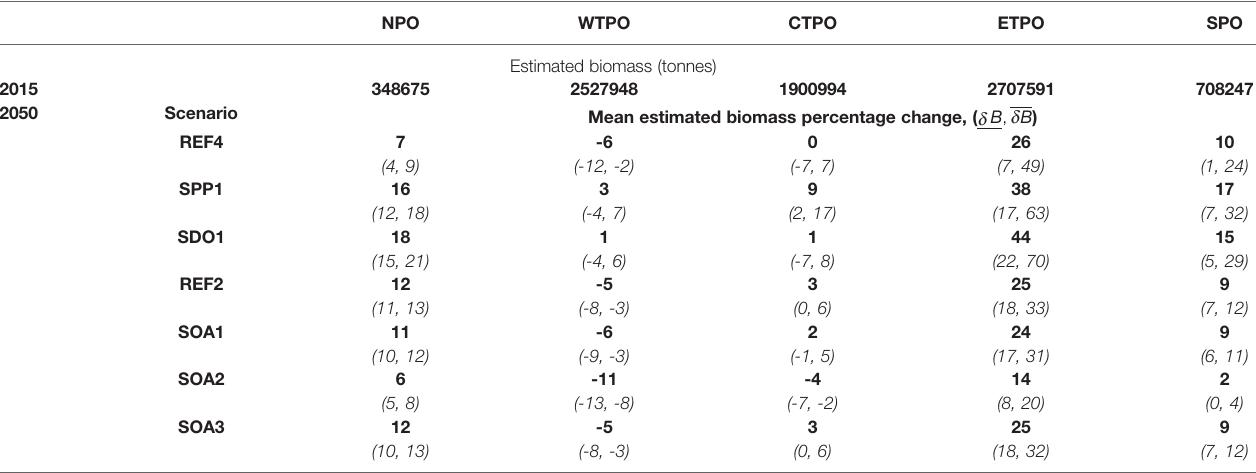
TABLE 2 | The variability of projected changes (de fi ned as the difference between the projected and reference biomass relative to the reference biomass) by large oceanic region and each model forcing for the yellow fi n tuna stock in 2050 (average over January 2046 – December 2055) from the ensemble simulations for Paci fi c regions.